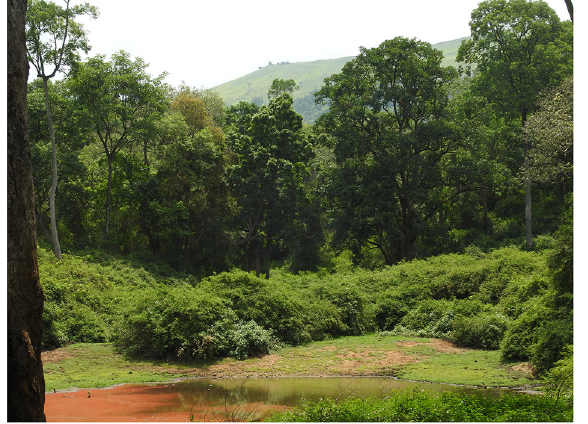
FIGURE 1 | The rock formations on top of the hill in the background are a sacred site known as Honnatti vi:ru . Thick undergrowth of Lantana blocks the flow of rain water from the hill tops to smaller waterholes like this one, and forces animals and humans to use the same paths (Photo: Samira